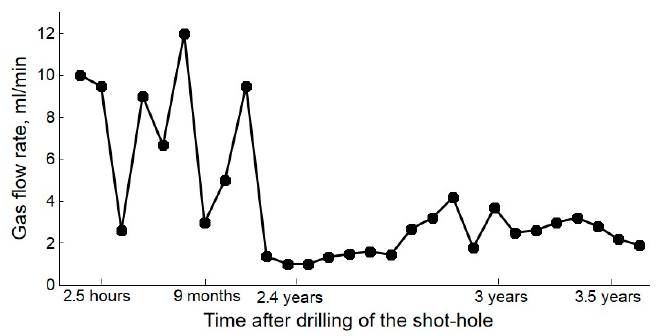
Figure 10. Temporal variations in gas flow rate, shot-hole # 25-1 (from [19], with minor modifications).